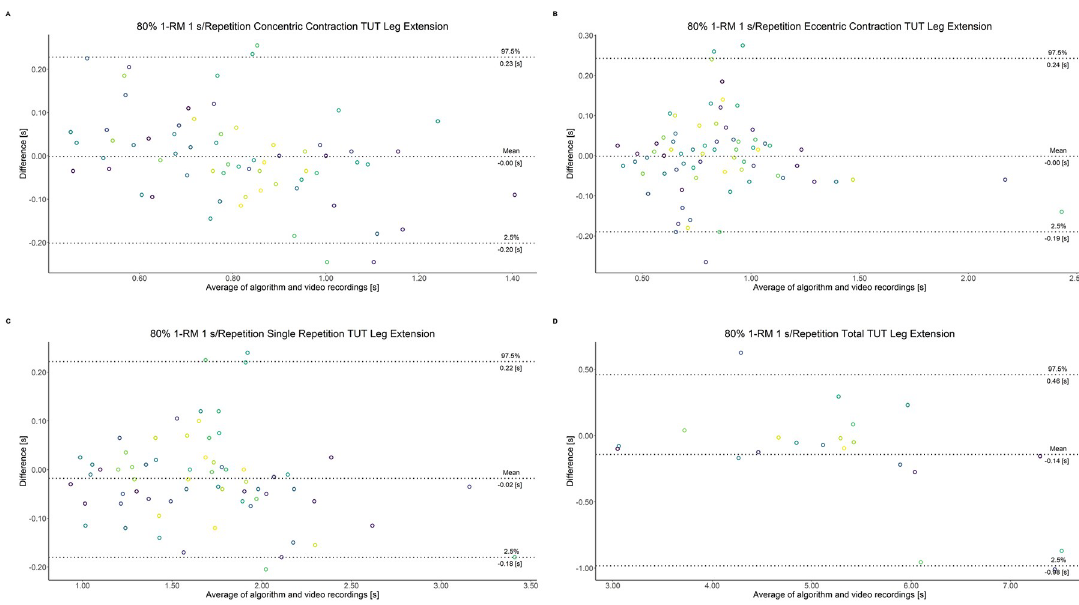
Fig 11. Bland-Altman plots of agreement between algorithmically accelerometer derived and video recordings derived contraction-specific phases of the leg extension machine at 80% 1-RM with a velocity of 1 s per repetition. A: Concentric contraction phase. B: Eccentric contraction phase. C: Single repetition. D: Total time-under-tension.